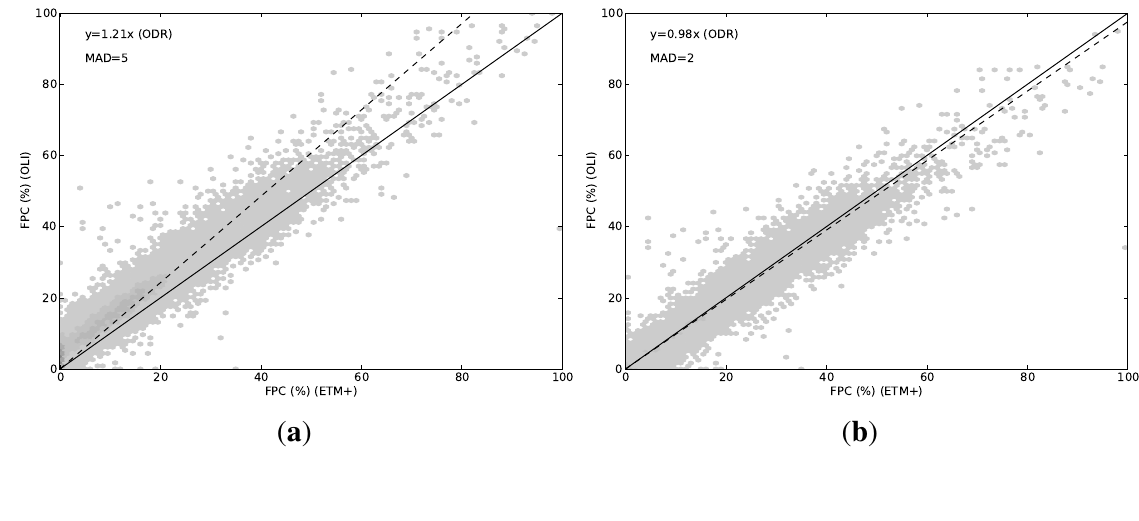
Figure 4. Foliage projective cover (FPC) for Landsat-7 and Landsat-8. ( a ) FPC using unadjusted TOA reflectance as input; ( b ) FPC using OLI TOA reflectance adjusted by fitted regression to match ETM+. Solid line is the one-to-one line, dashed line is the ODR